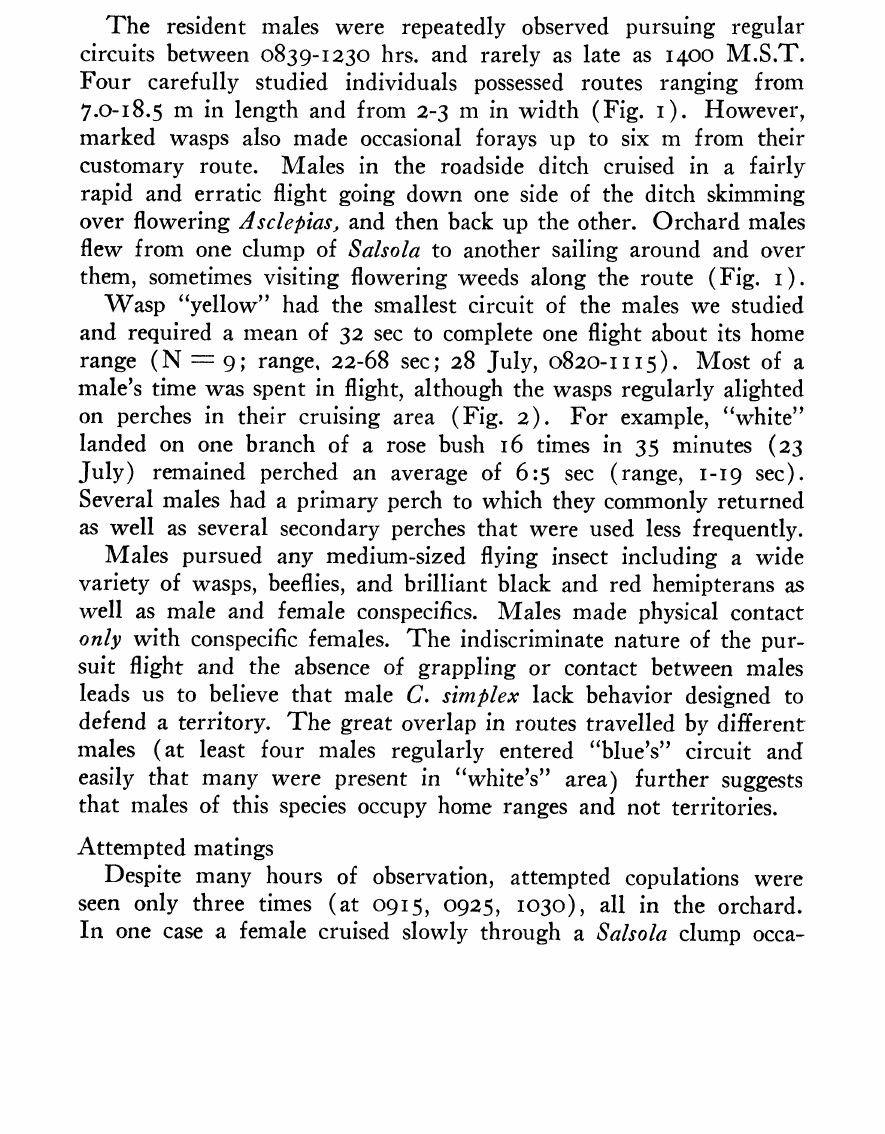
Table 1. Site attachment of male C. simplex. A total of sixteen individuals marked 23-27